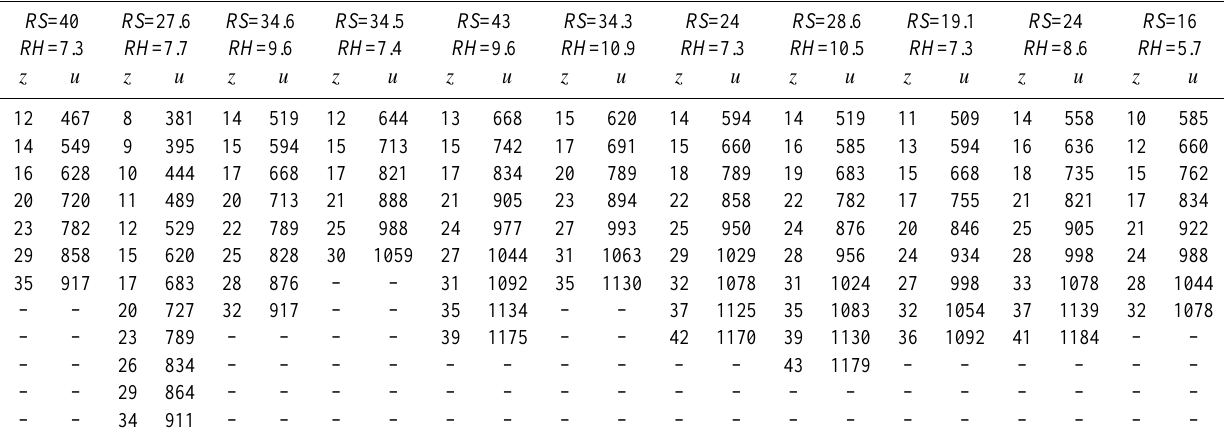
Table 1. Selected parameters for the determination of the aerodynamic roughness length ( z 0 ) and the displacement height ( D ) for various ridges characteristics (spacing: RS ; height: RH ).